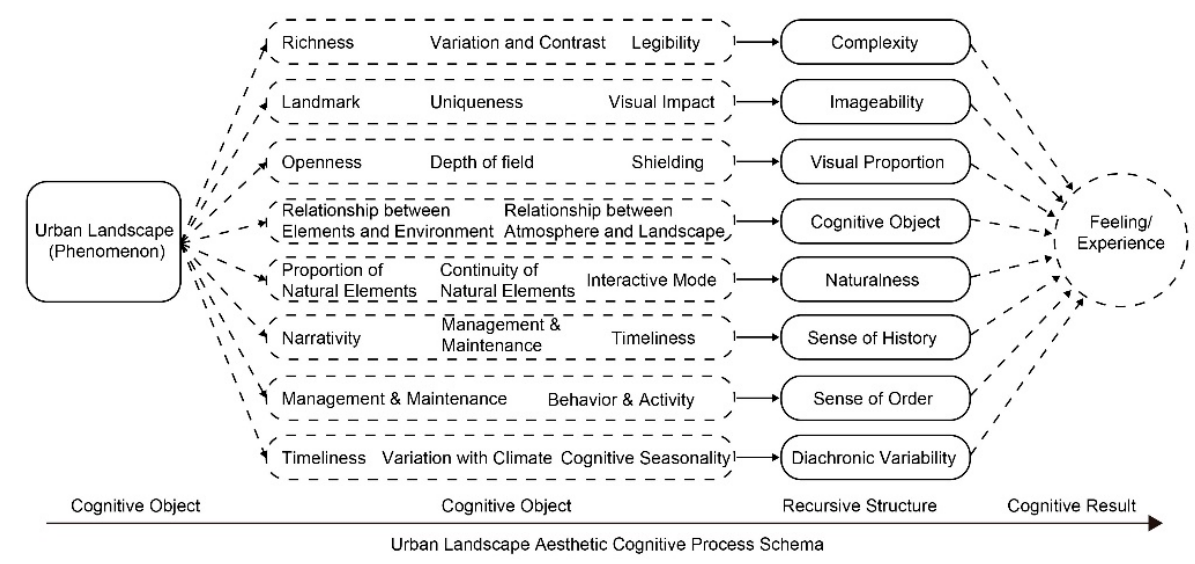
Figure 4. Function of Representation and Structure of Urban Landscape Aesthetic Cognitive Schema in Cognitive